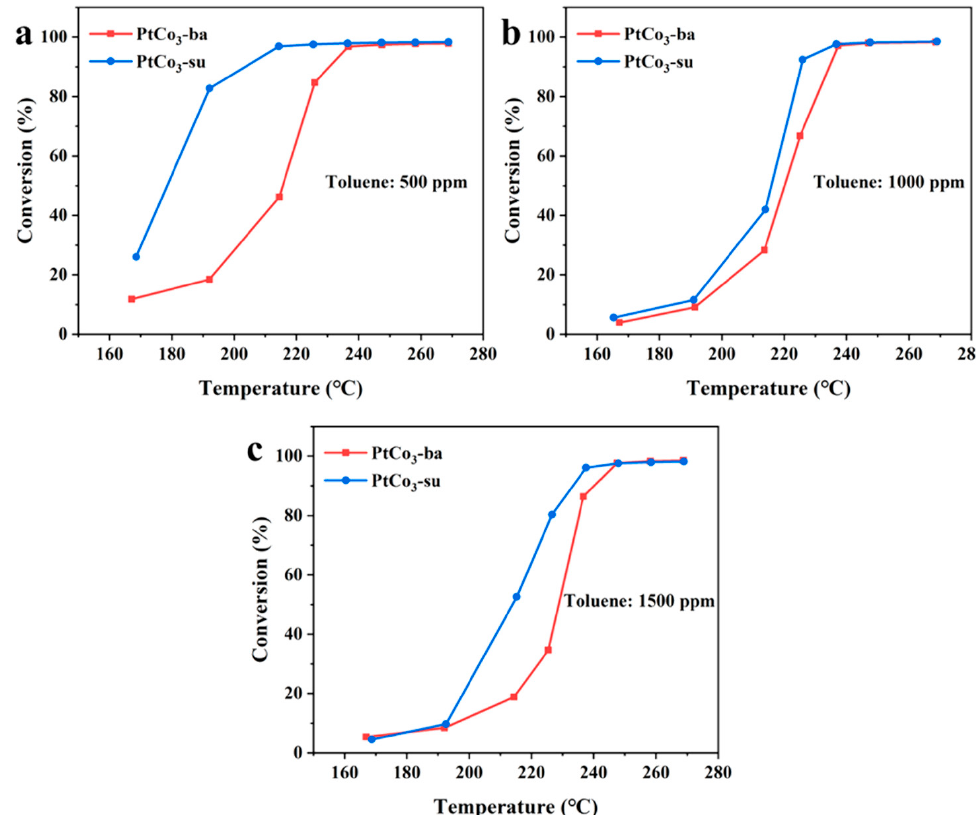
Figure 2. Conversion rates of as-synthesized samples at 500 ppm ( a ), 1000 ppm ( b ), 1500 ppm ( c ).